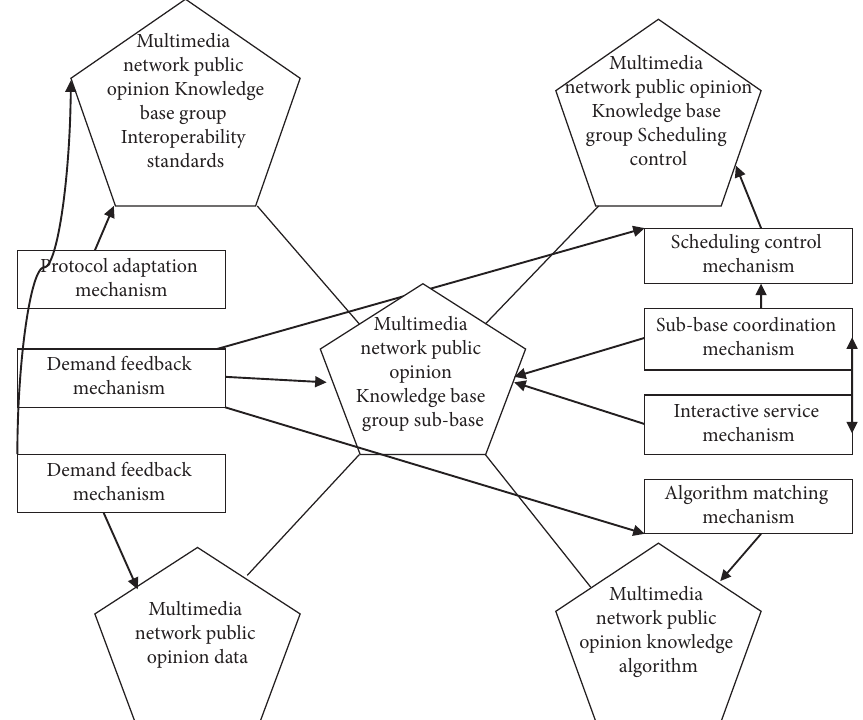
Figure 5: The relationship between the interoperable components and mechanisms of the multimedia network knowledge base